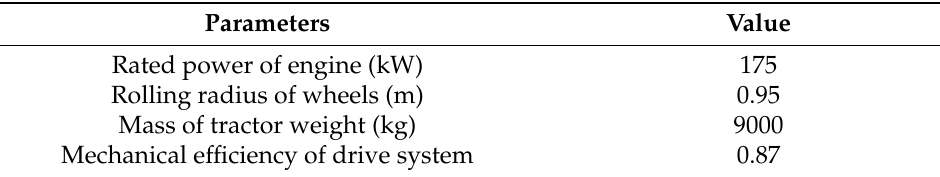
Figure 7. The interface and structure of the simulation model. Table 1. Basic parameters of the simulation tractor.